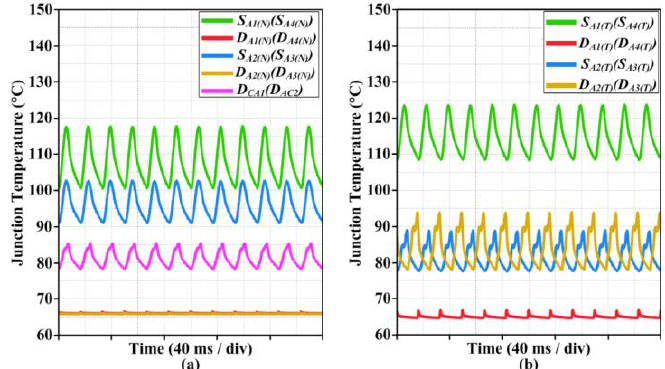
Figure 7. Junction temperatures of the power devices at the rated power when f sw = 20 kHz and R th(h-a) R th(h − a) = 0.225 K / W: ( a ) NPC inverter; ( b ) T-type inverter. = 0.225 K/W: ( a ) NPC inverter; ( b ) T-type inverter.